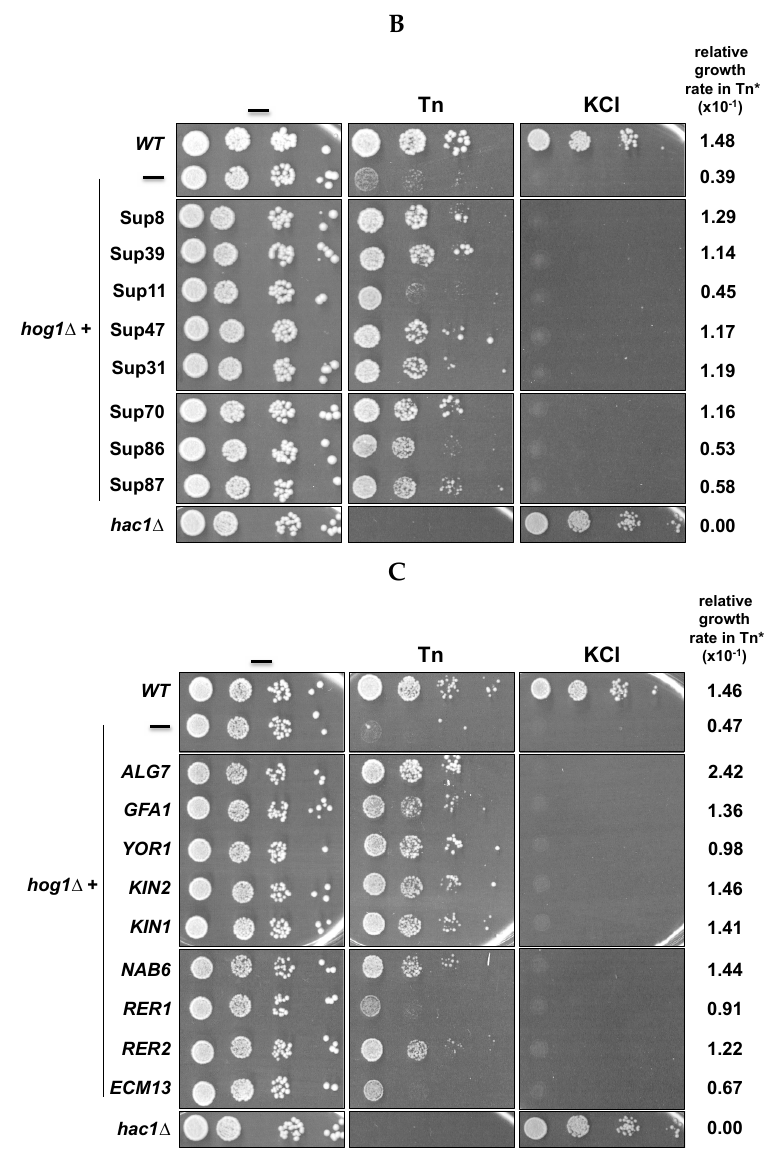
Figure 2. Suppression of the hog1 ∆ Tn sensitivity. ( A ) Schematic representation of the genomic region contained in each suppressor plasmid. Chromosome number and insert coordinates and size are shown. Number of isolated times that each suppressor plasmid was isolated along with its relative suppression level (according to Figure 2B) are indicated. ORF orientation is depicted by the colored arrows. ORFs that show suppressor activity are marked in brown. ( B ) Serial dilution dropping assay of the hog1 ∆ strain transformed with suppressor plasmids. Yeast cells were grown in YPD to early ‐ logarithmic phase and adjusted to 0.5 OD 600 in fresh YPD. 10 ‐ fold serial dilutions were spotted on selective medium (see legend of Figure 1) containing either 0.5 μ g/mL Tn or 1 M KCl. The hac1 ∆ mutant was used as Tn sensitivity control. Plates were incubated at 30 °C for 72 h and scanned. ( C ) Genes colored in brown in Figure 2A were subcloned into the multicopy plasmid YEp352 and expressed in the hog1 ∆ strain under the control of their own promoter. A serial dilution assay was performed as described in Figure legend 2B. (*) The relative growth rate is the slope value of the linear regression of liquid cultures made in triplicate and grown in YPD containing 0.5 μ g/mL Tn. Liquid cultures were performed in a microplate spectrophotometer at 30 °C with constant shaking. The OD 600 readings were determined at 1 h intervals during 48 h. KIN1, which was not detected in the screening was included in this assay since it is paralogous to KIN2 (see text).